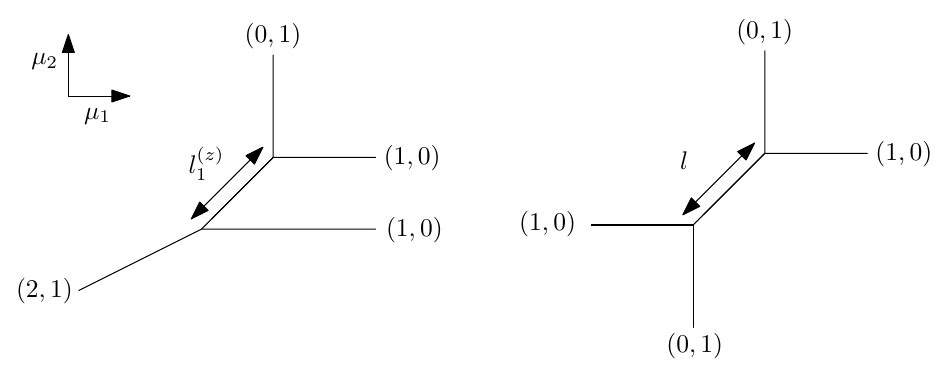
^C ] C on the left and the resolved conifold ] CY 3 2 = Z CY 3 2 ; 0 = 2 (cid:2)